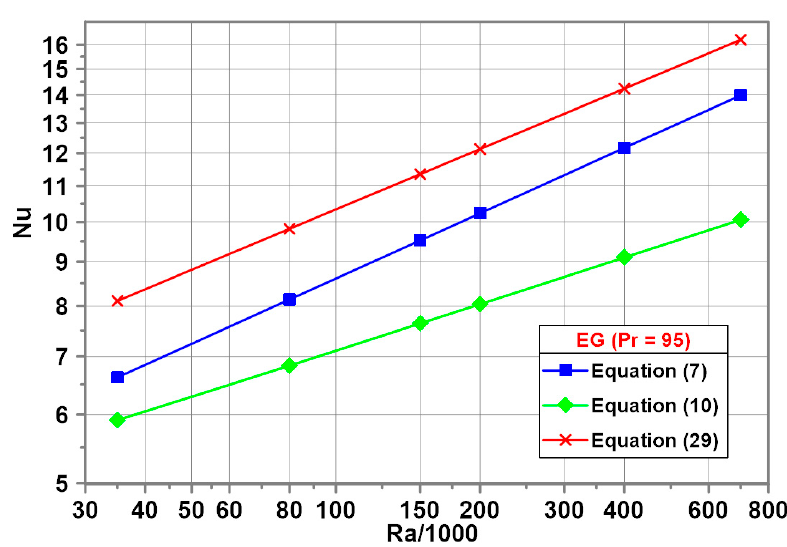
Figure 9. Present Nu-Ra relationship vs. predictions from literature correlations which relate Nusselt number to Rayleigh number and dimensionless vertical wall spacing.